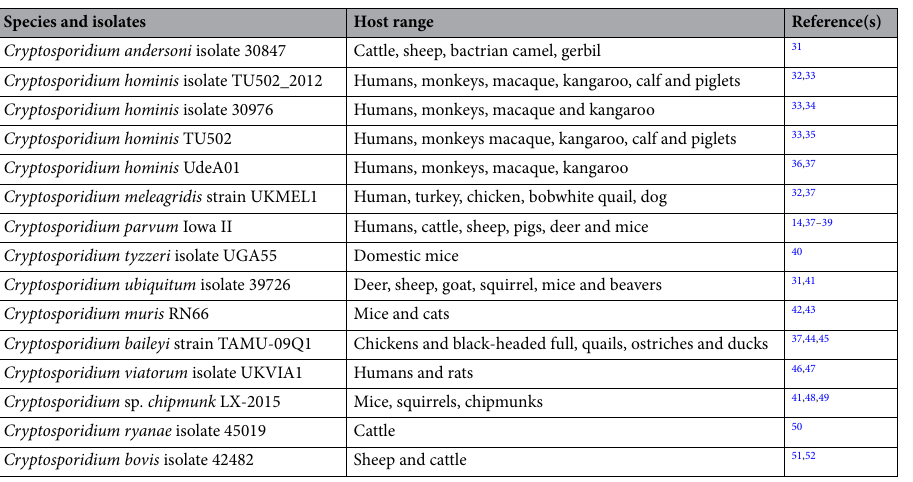
Table 1. Cryptosporidium species used in the study and their major host